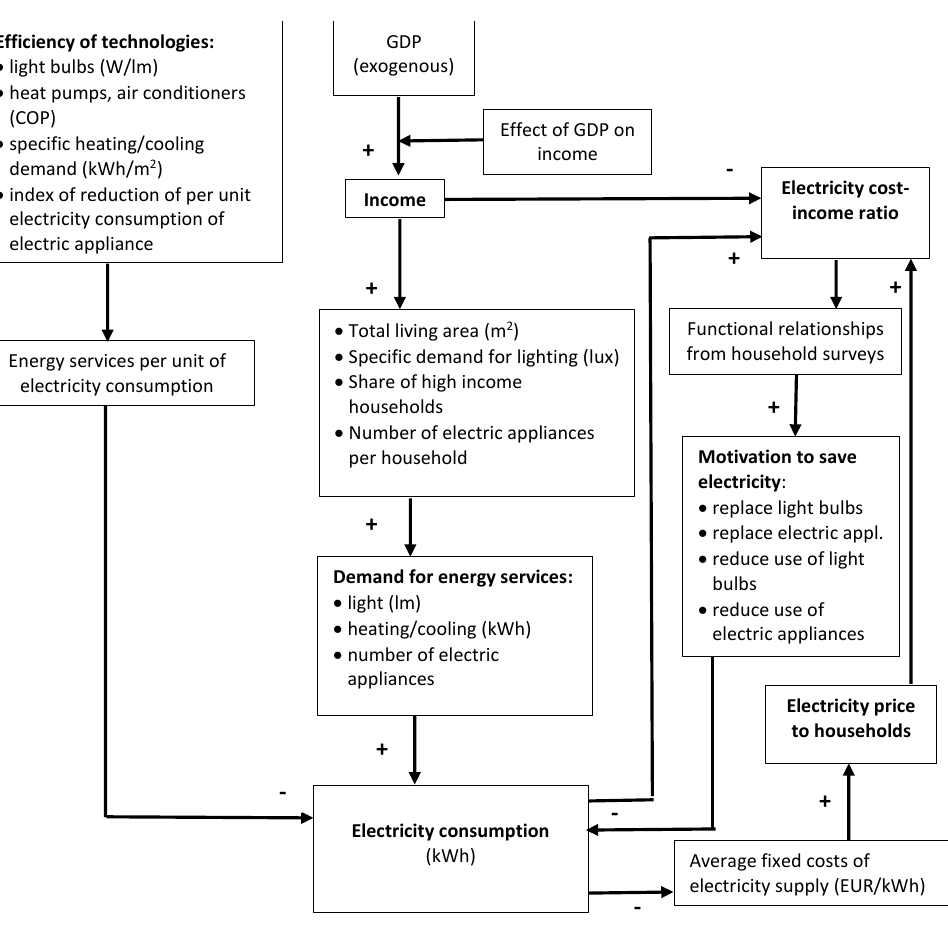
Fig. 2. Structure of the model – a sector